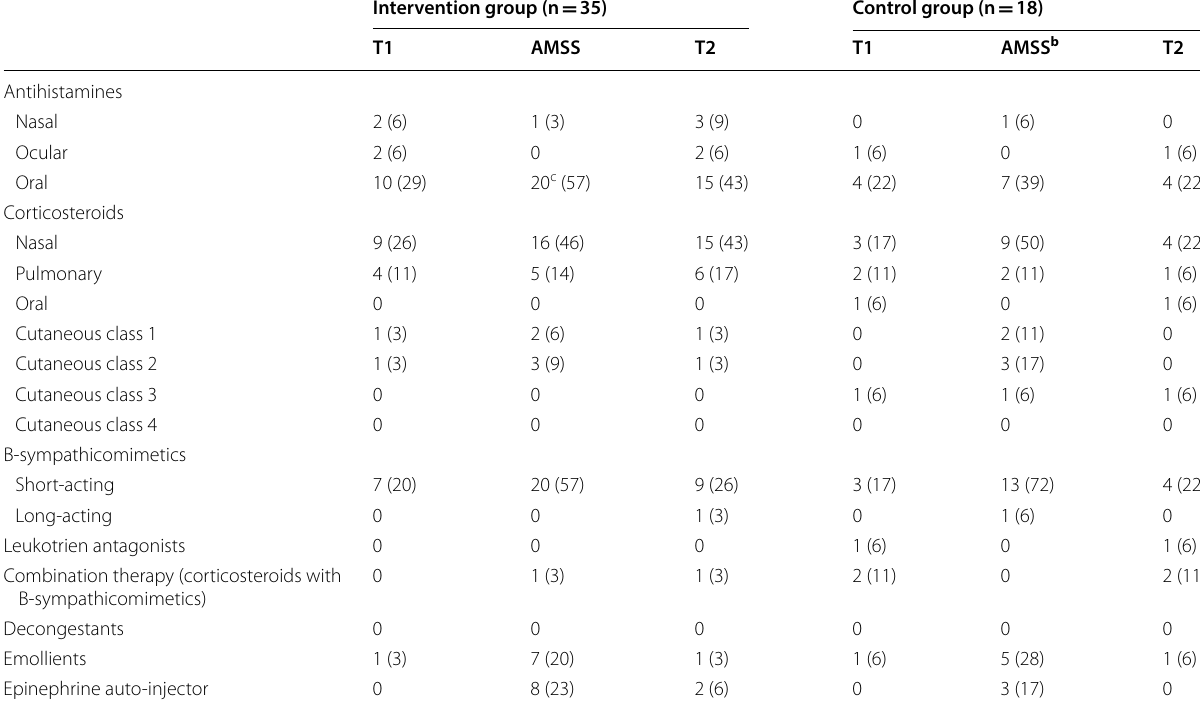
Table 3 Medication a reported by the GPs in intervention group and control group at T1 and T2 and the medication recommendations of the